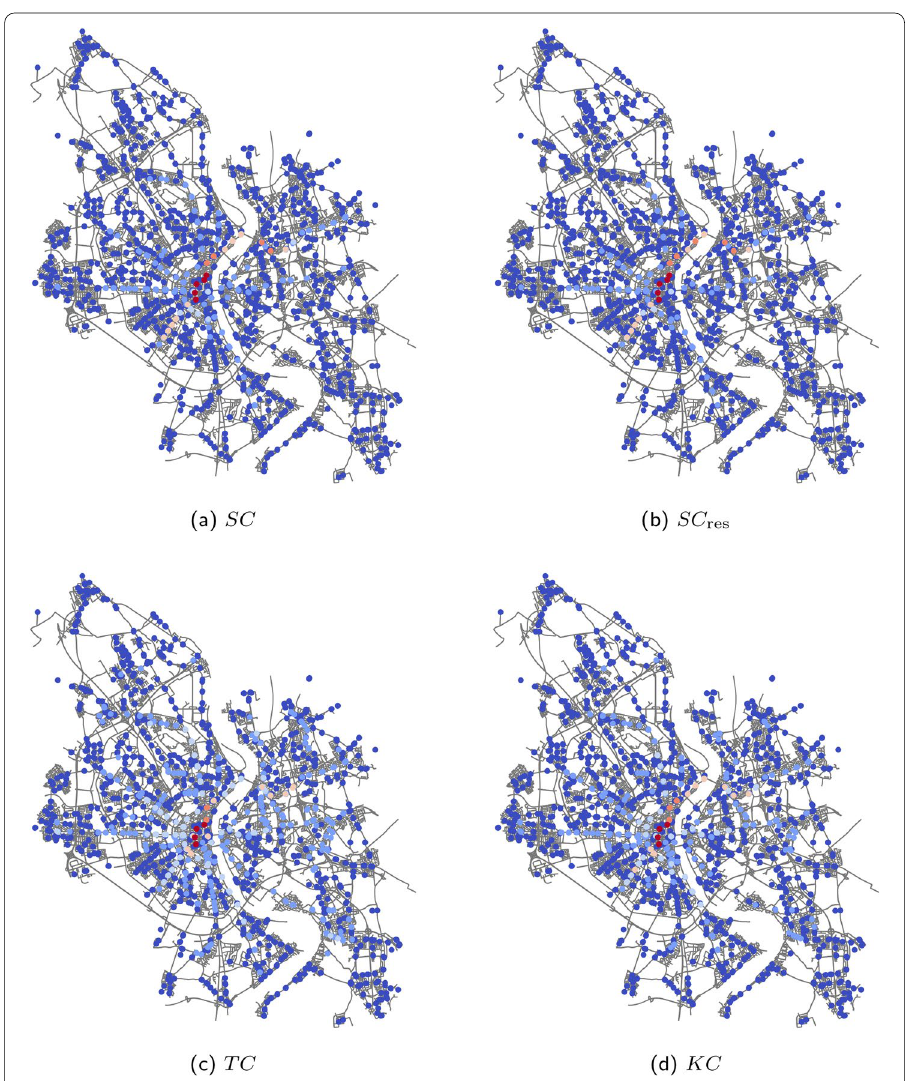
Fig. 8 Comparison of the four different matrix function-based centralities at the example of marginal node centralities of Cologne. Central stops are marked red and non-central stops are marked blue. The entries in the supra-adjacency matrix are weighted with travel times and frequencies. The parameters are set to α = β = 0.5 / (cid:31) max , σ = 5 , and (cid:31) t transfer = 5 . The street network in the background of the plots is created with the OSMnx python package (Boeing